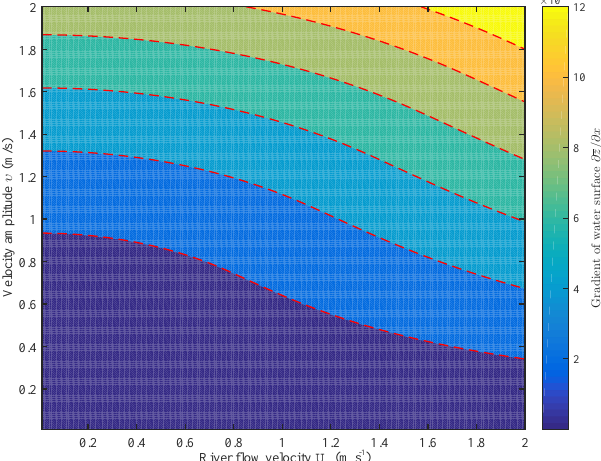
Figure 4. Contour plot of the water surface gradient ∂z/∂x (Eq. 17) as a function of river flow velocity U r and tidal velocity amplitude υ for given tidally averaged depth h = 10m, Manning–Strickler fric- tion coefficient K = 45m 1 / 3 s − 1 .